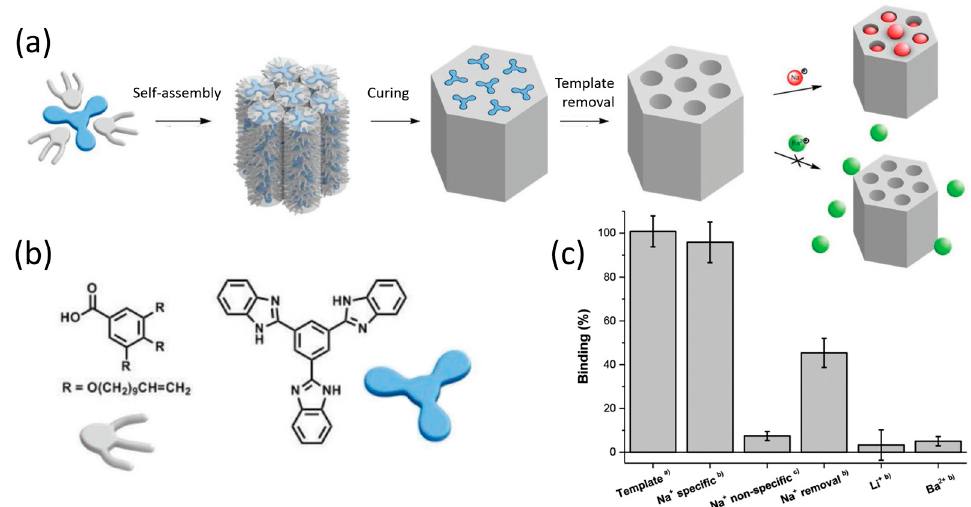
Figure 4 . Nanoporous polymers using a gallic acid derived monomer and tris-benzimidazole template. ( a ) Scheme illustrating monomer self-assembly, polymerisation, template removal, and selective